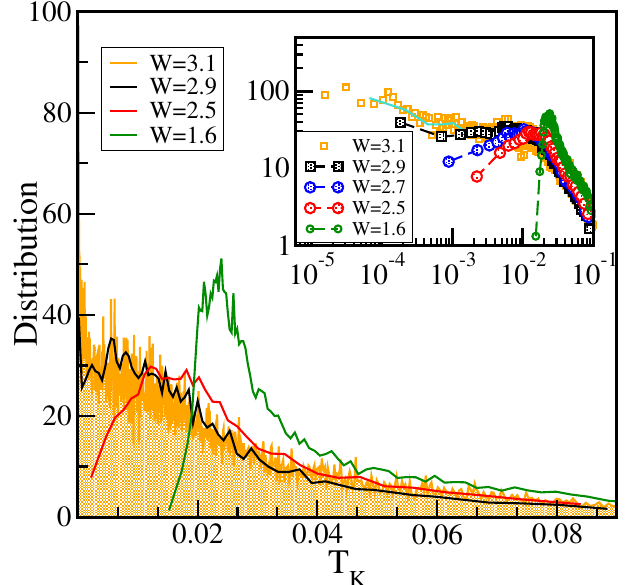
Figure 42. Distribution of Kondo scales vs. T K for various disorder values in the 3D Anderson-Hubbard model (units 4 t = 1). For larger W values, the distribution develops a finite intercept. The inset shows the same data on a log-linear scale. Reprint from